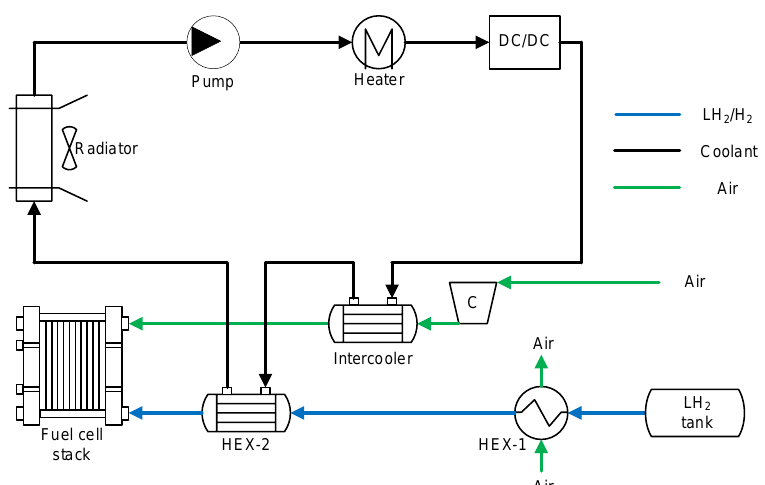
Figure 1. Scheme of original LH 2 system.